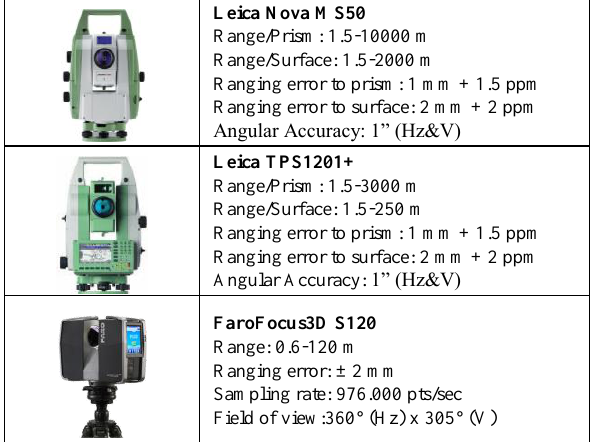
Figure 1. Left: San Luzi church bell tower. Right: cross section of the bell tower with its floor plan